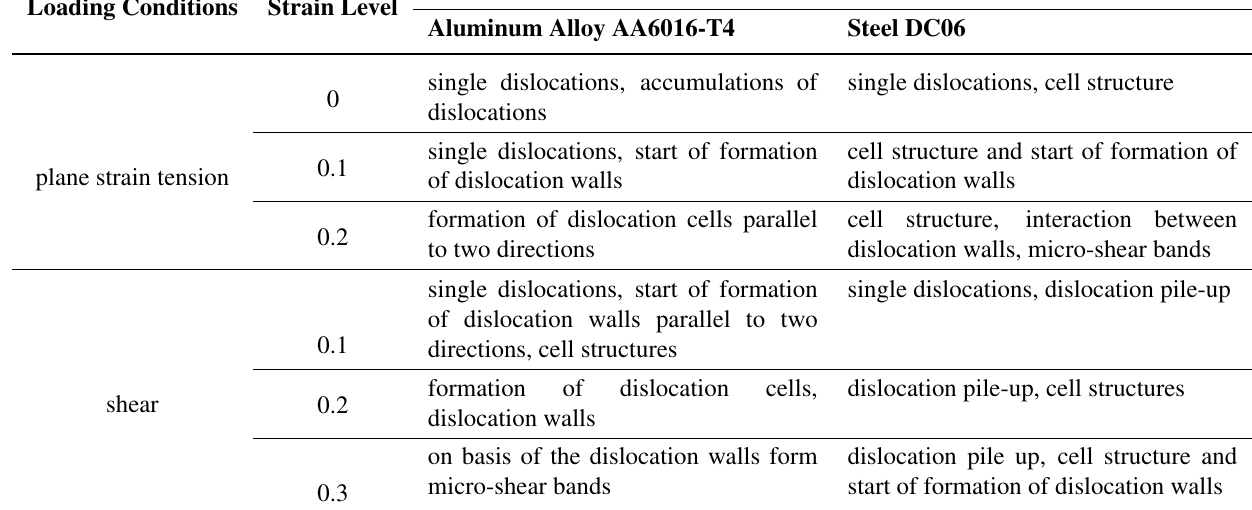
Table 4. Characteristics of dislocation structures under plane strain deformation in aluminum alloy AA6016-T4 and steel